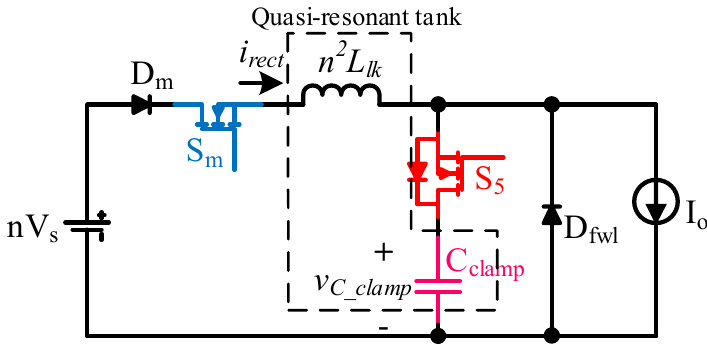
Figure 5. Simplified equivalent circuit model of the proposed converter.